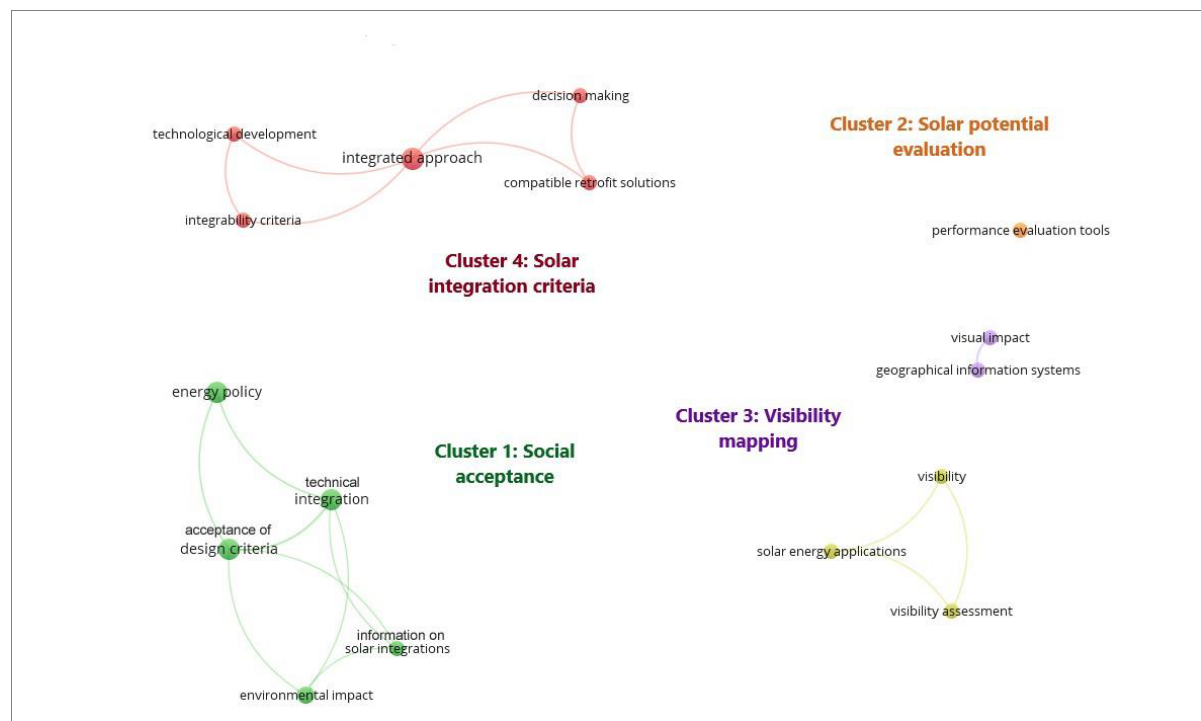
Figure 4. Main clusters of the studies based on co-occurrence network of the selected indexed key- words on solar energies and architectural heritage (source: Author ’ s elaboration using VOSviewer, based on Scopus data).